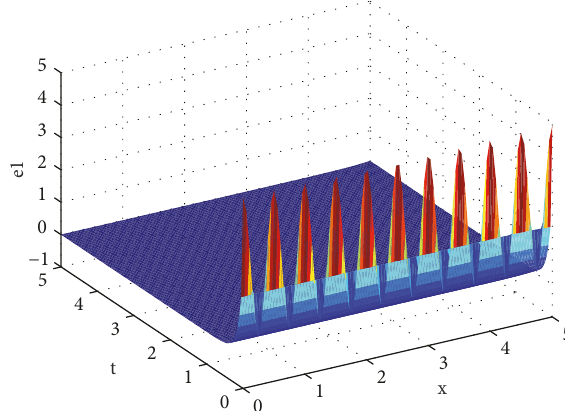
Figure 7: Timeevolution ofthe linearsynchronizationcontrolerror 𝑒